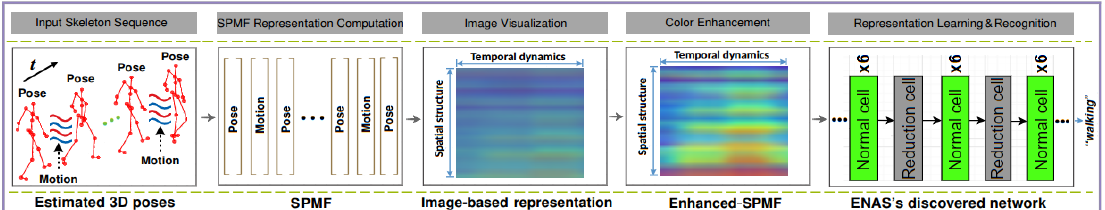
Figure 6. Illustration of the proposed approach for 3D pose-based action